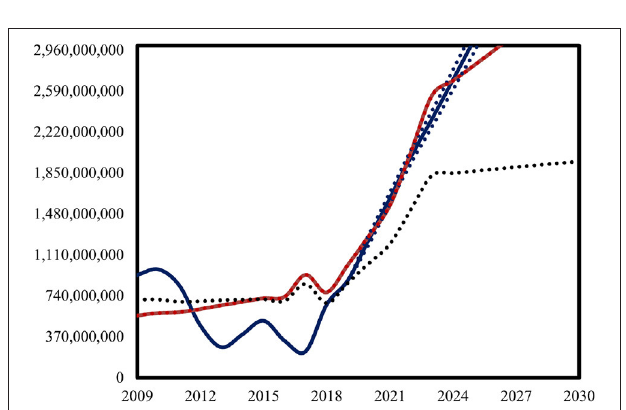
FIGURE 4 | Focus on the ETS CO 2 -equivalent (tCO 2 e) cost dynamics. The x -axis represents the time-line. The y -axis measures the optional cost values of carbon allowances. The blue line corresponds to the levels of cost calls (optional cost values). The blue dotted lines indicate the standard deviation of the cost calls. The red line corresponds to the levels of cost puts (optional benefit values). The black dotted line corresponds to the down-barrier optional cost values according to the public recommendations both in terms of carbon prices and reductions of the CO 2 -equivalent